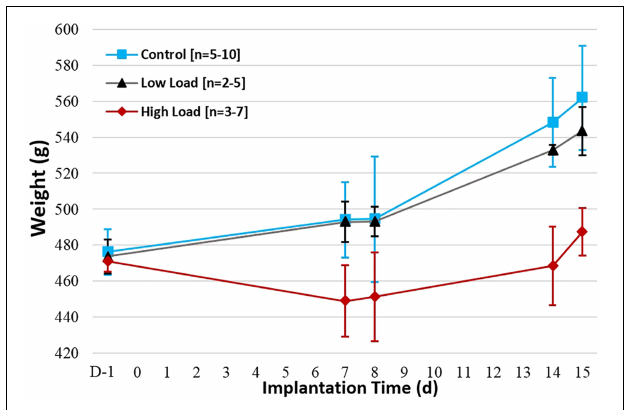
FIGURE 1 | Average weight evolution per group over implantation period (days). Initial weight value is taken one day preoperatively (D-1).